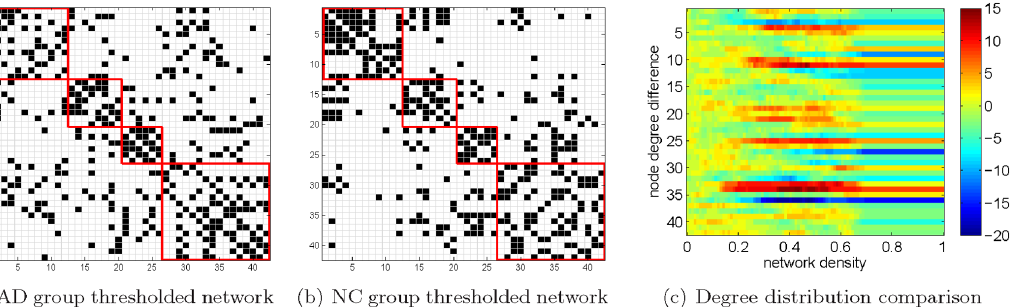
Fig 8. Comparison between the AD and NC networks learned by GRM. (a)-(b) correspond to the adjacency matrices of thresholded networks with both 187 edges, respectively; (c) visualizes the degree distribution differences between the AD and NC networks, with respect to the network density. Both the horizontal and vertical axes in the first two diagrams represent the brain region